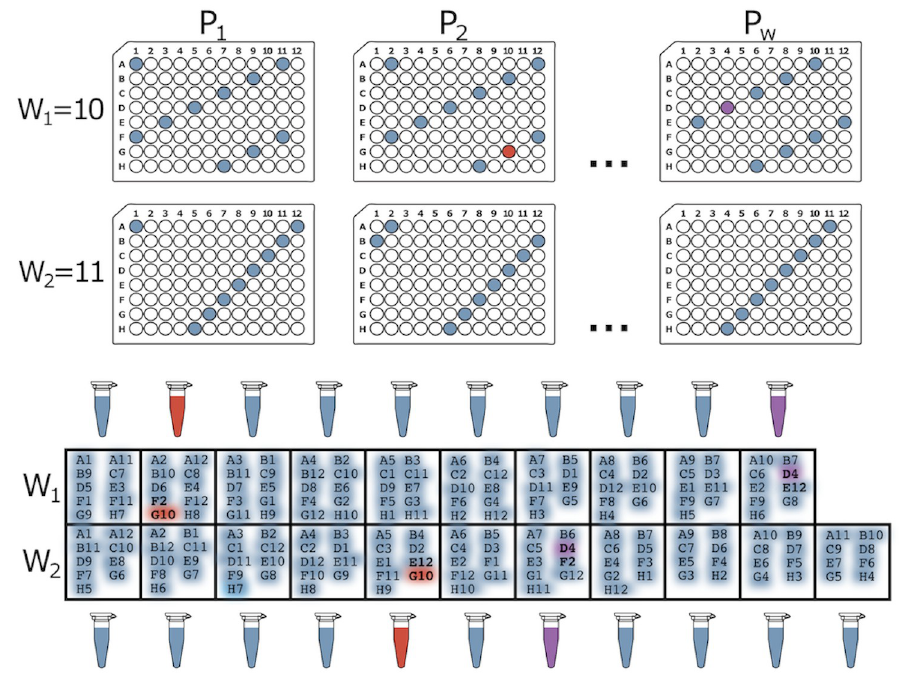
Fig 1. DNA Sudoku pooling example. In this example, there are a total of N = 96 samples. The 96-well plates show which samples are combined into each pool ( P i ) for the two different window sizes ( W 1 = 10 and W 2 = 11 which are ffiffiffiffi p greater than and co-prime). By using two different window sizes, the weight of this pooling design is w = 2 N meaning that k = w − 1 = 1 positive sample can be unambiguously identified in a single step using T = W 1 + W 2 = 21 tests. The positive samples are decoded by finding the samples that appear most often in the positive pools. For example, if G10 is the only positive sample, we can detect this from the pooling results by noticing that G10 was added to both of the positive (red) pools while the other samples in those pools were added to only one or the other. Alternatively, if both G10 and D4 are positive, four samples occur with equal frequency (D4, G10, E12, and F2) in the positive pools (red and purple) and it is impossible to determine which are the true positive samples. This ambiguity is introduced because the test was designed to handle only one positive